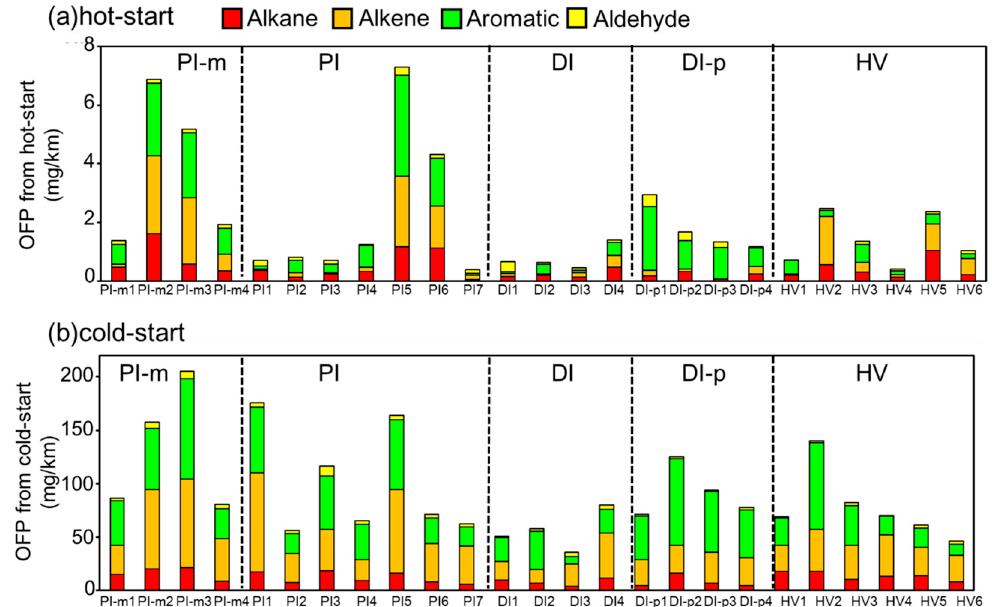
Figure 2. Ozone formation potential (OFP) for the 25 vehicles measured in this study following a ( a ) hot-start and ( b ) cold-start. (PI-m: mini-sized port injection, PI: standard-sized port injection, DI: direct injection, DI-p: direct injection premium gasoline, and HV: hybrid vehicles).